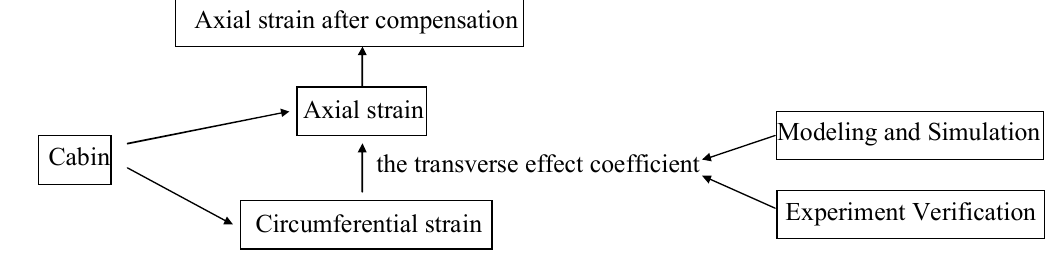
Figure 1. A graph with the mentioned methodology.